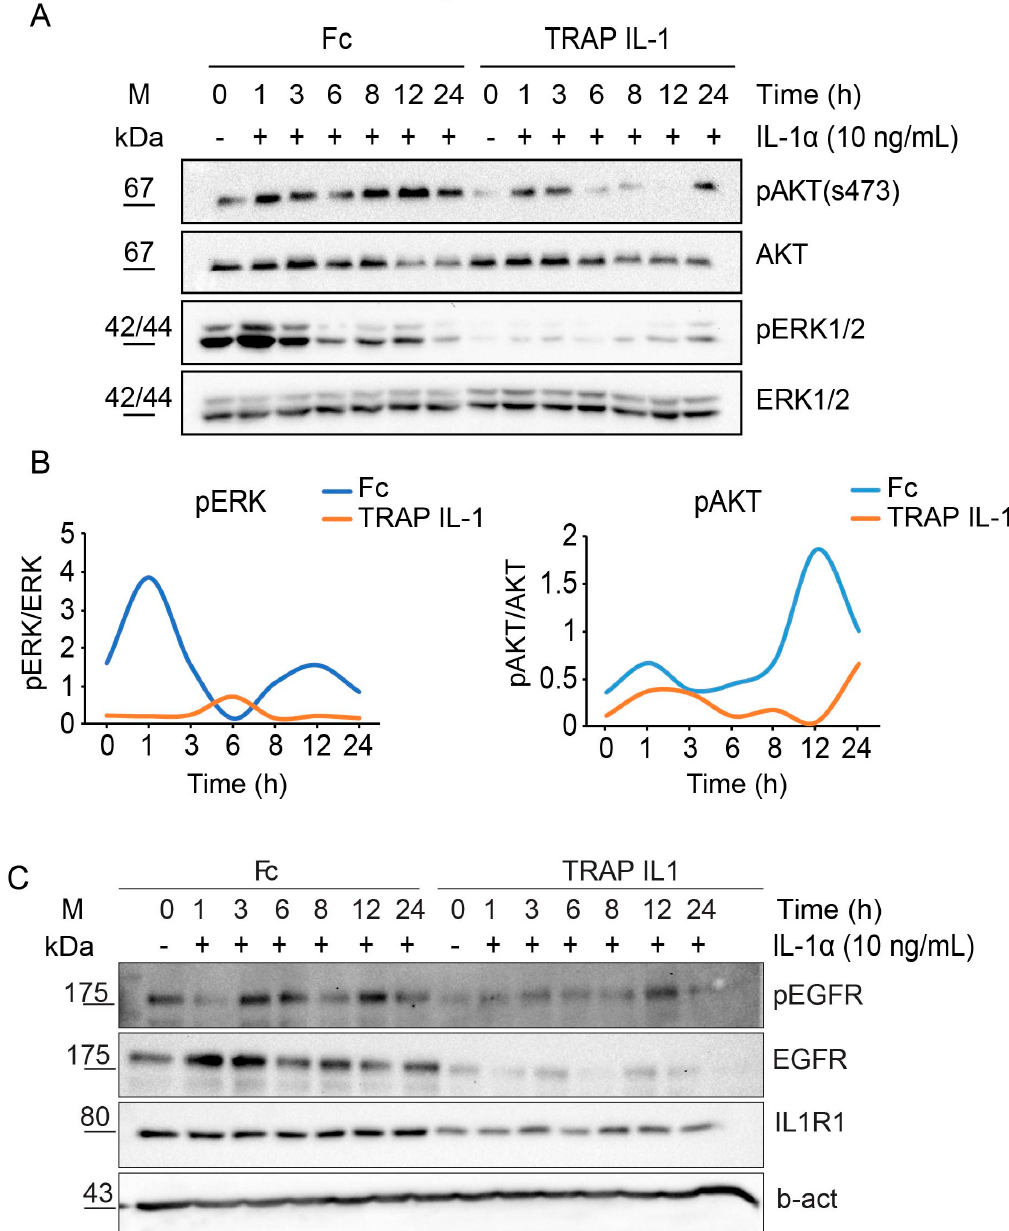
Figure 4. Bimodal activation of ERK and AKT after stimulation with IL-1A. ( A ) Western blot analysis of phospho-AKT s473 (pAKT) and phospho-ERK (pERK) levels in Caco-2 Fc and